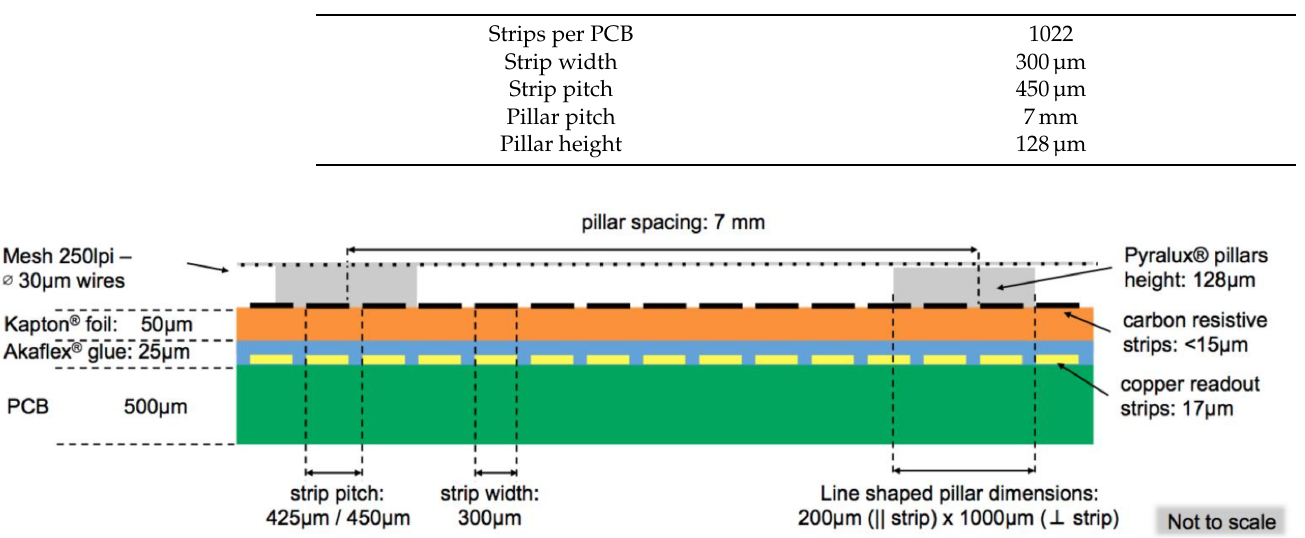
Table 1. Readout board parameters.